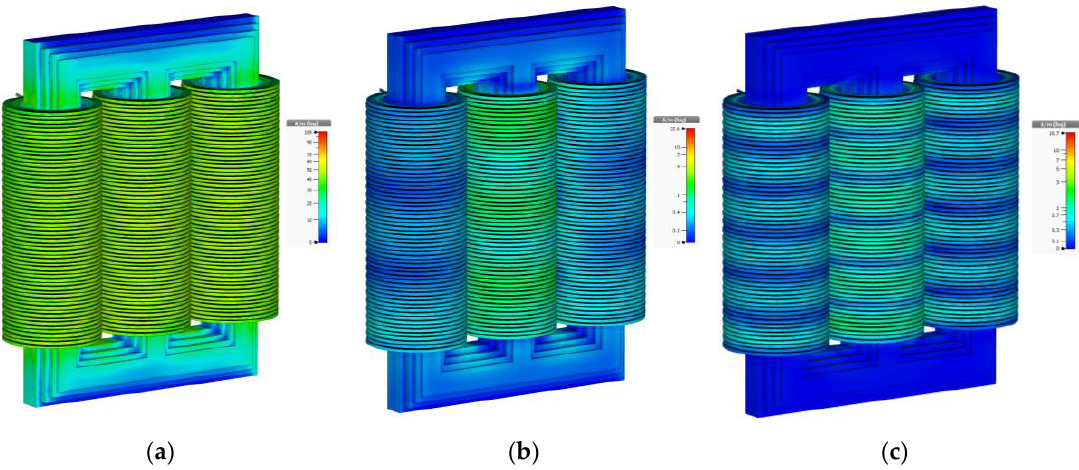
Figure 6. Magnetic field distribution in high-frequency (HF) model of three-phase transformer at different frequencies: ( a ) 20 Hz; ( b ) 500 kHz; ( c ) 1 MHz.